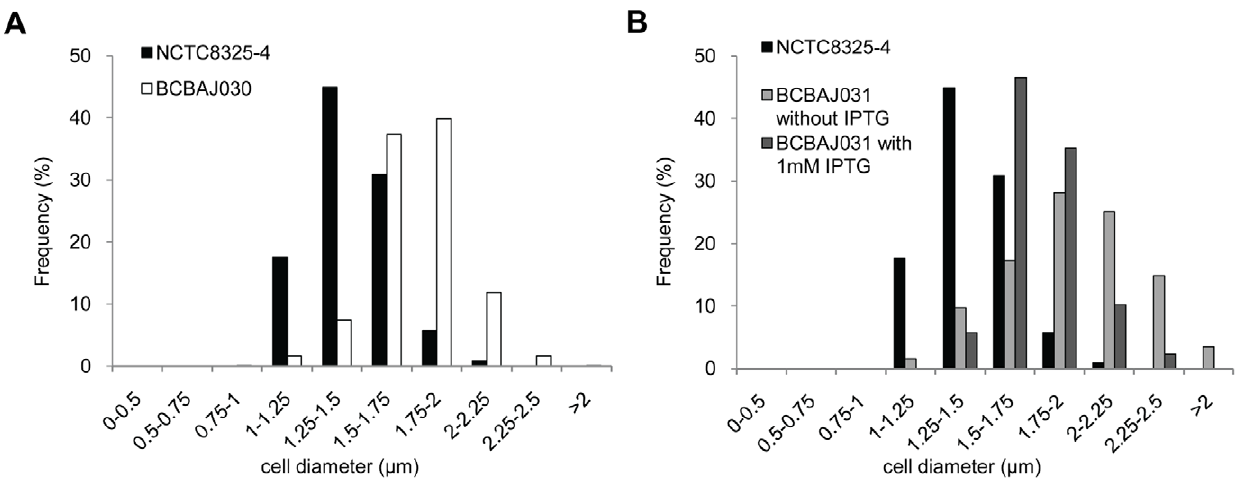
Figure 2. Absence of EzrA in S.aureus leads to an increase in cell diameter. Phase contrast images were used to measure the diameter of 600 to 1000 cells of each strain: wild type NCTC8325-4, null mutant BCBAJ030 (NCTC8325-4 D ezrA ), and ezrA conditional mutant BCBAJ031